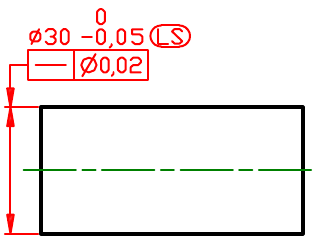
Figure 5. In the ISO GPS system, the straightness tolerance for derived median line and the size tolerance with modifier local size defined by a sphere (letters LS placed in in the elongated circle) defines identical requirements as the specifications given in Figure 4a.